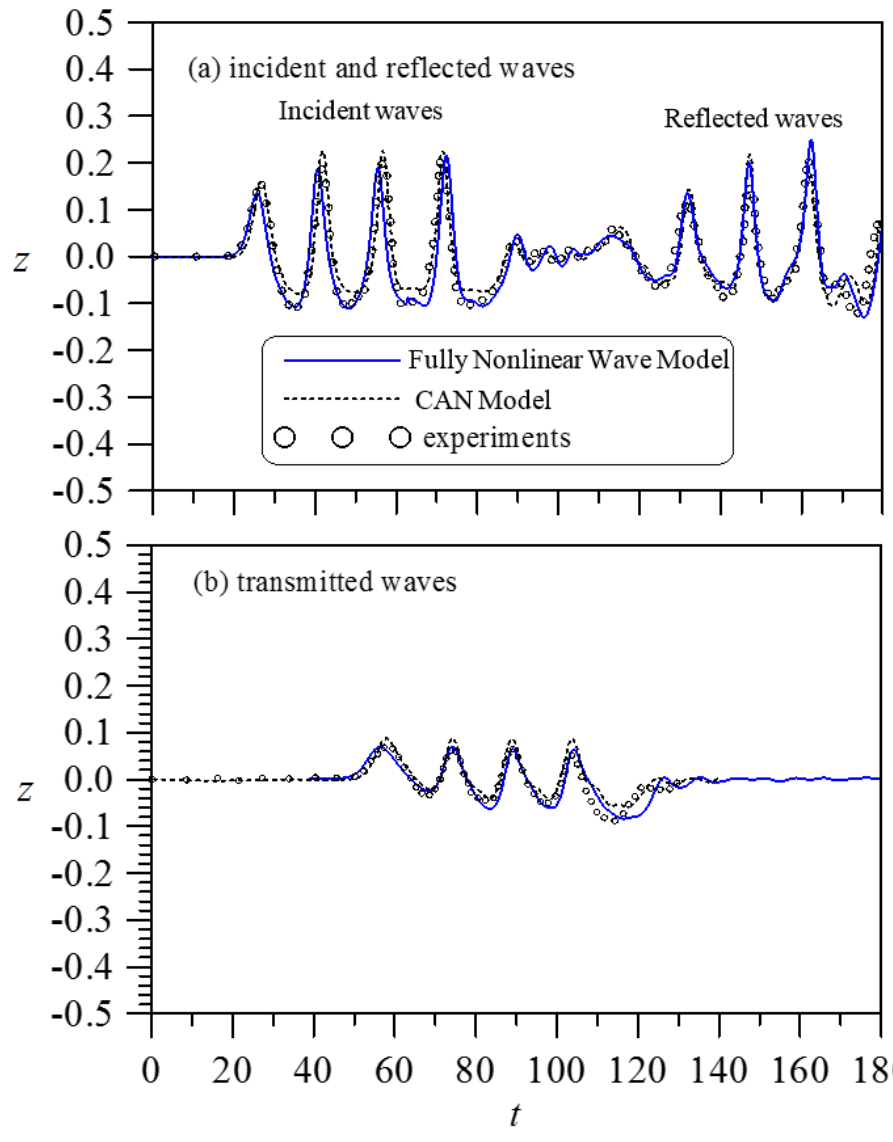
Figure 5. Comparisons of the incident and reflected wave profiles in subplot ( a ) and transmitted wave profiles in subplot ( b ) obtained from the present CAN model, a FNWM, and measured data for a cnoidal wave encountering a partially submerged body with h 1 = 0.5, L = 4. The incident cnoidal wave conditions are α = 0.3 and λ = 15.